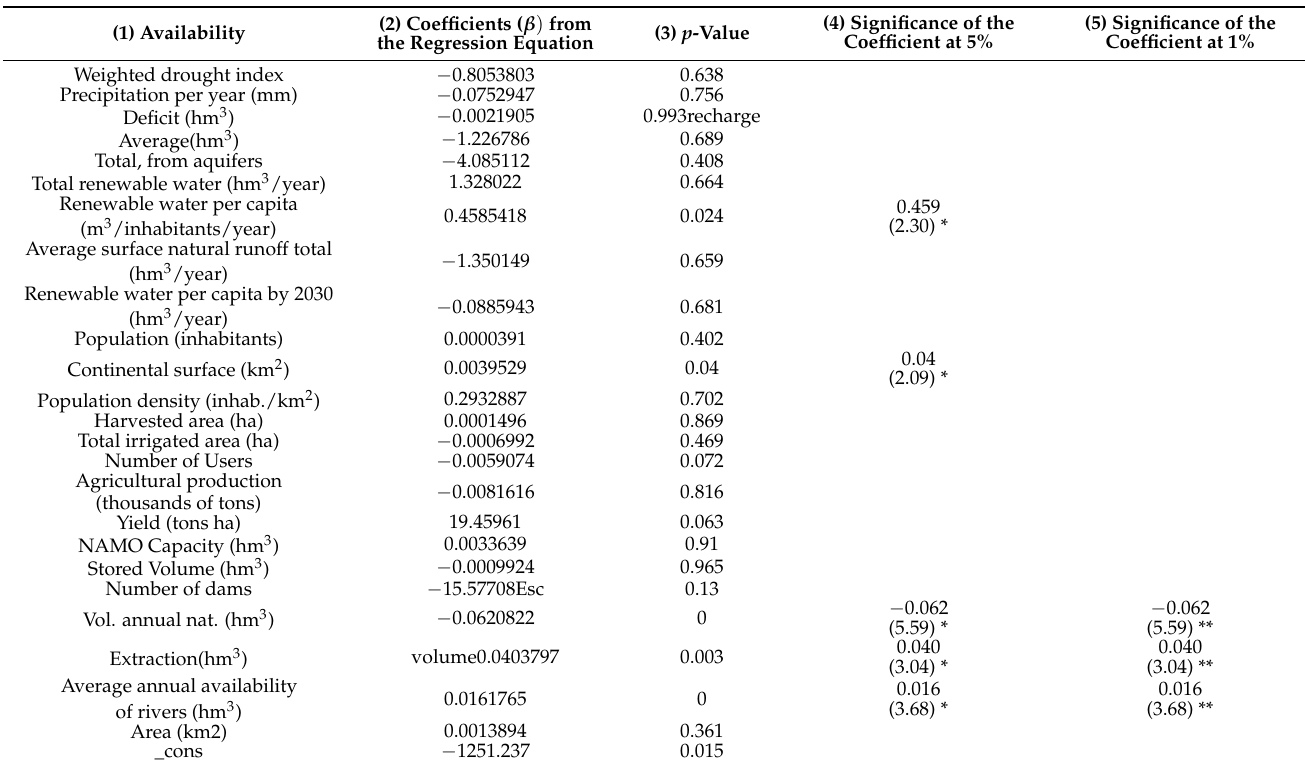
Table 2. Coefficients ( β ) and their statistical significance values ( p -value, 5% and 1%) corresponding to the proposed base model about 25 related predictor variables between